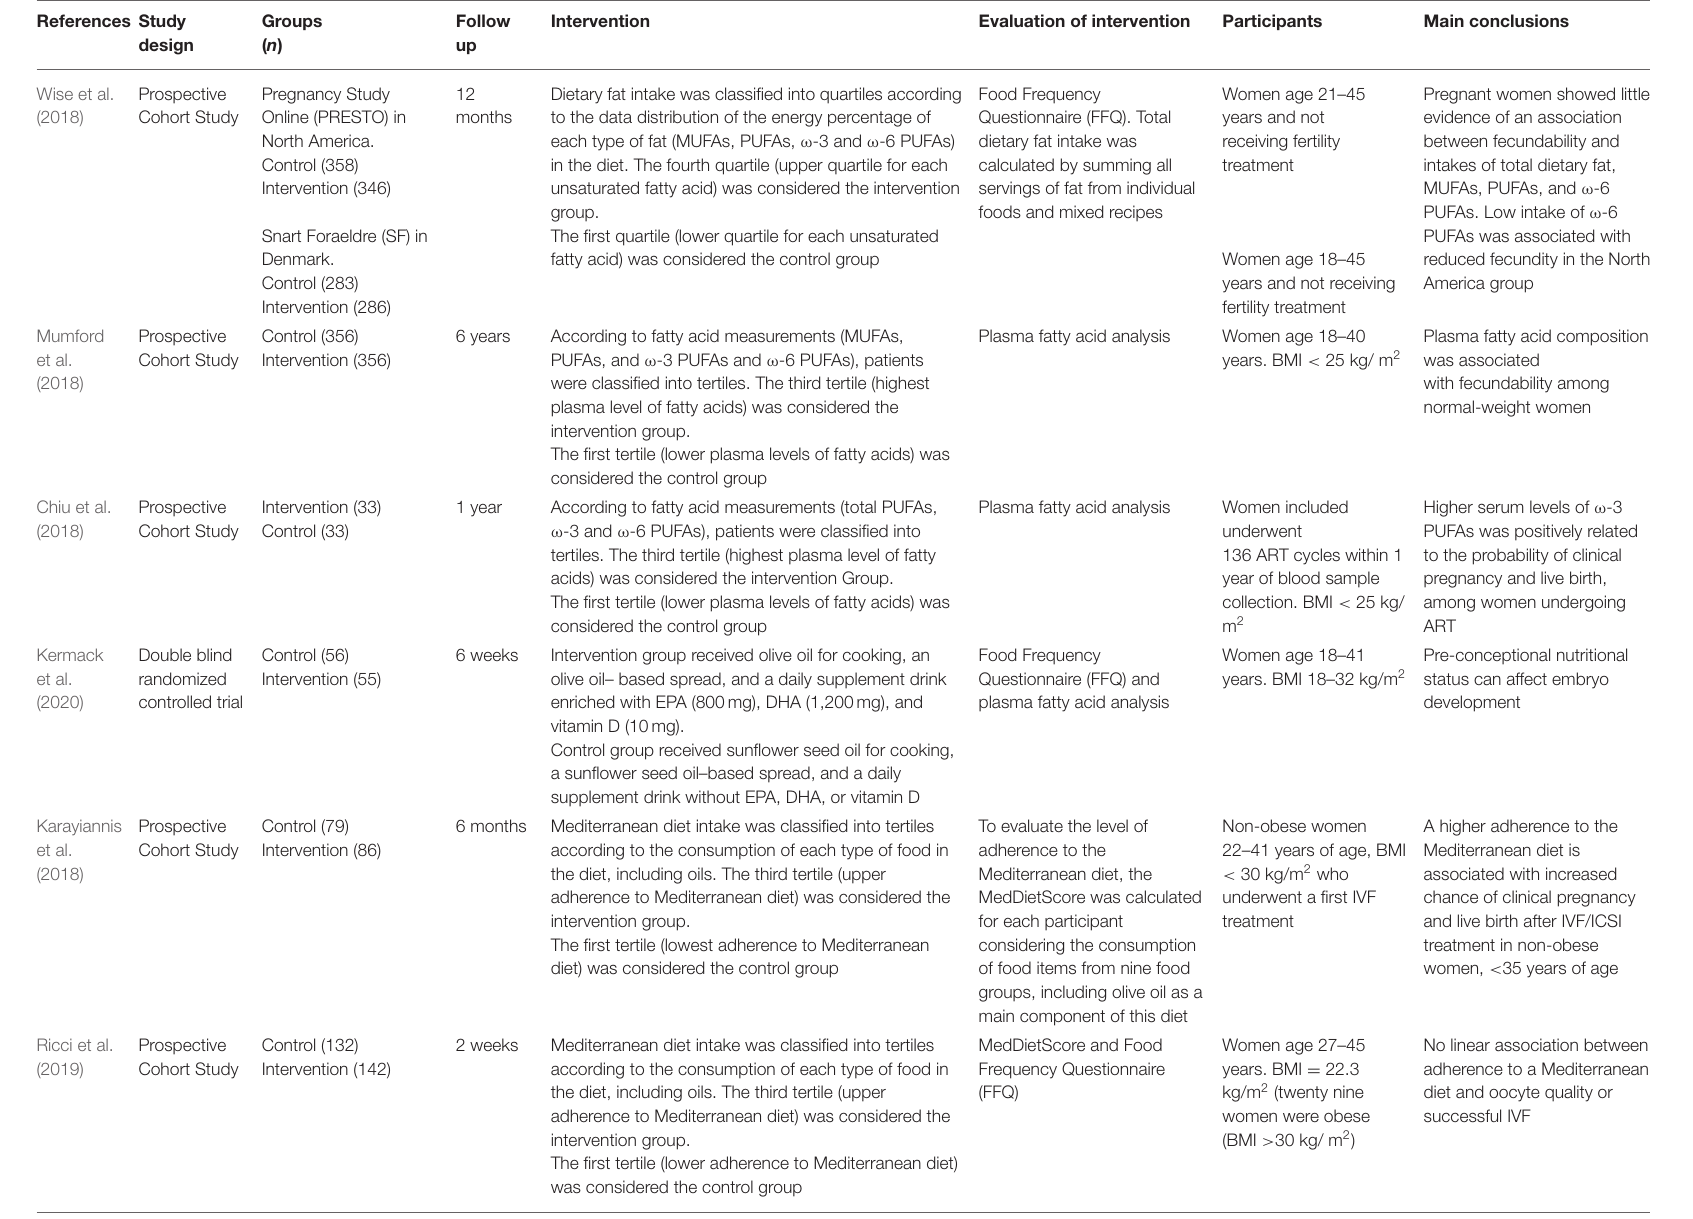
TABLE 1 | Characteristis of studies on the association between periconceptional intake of unsaturated fatty acids and